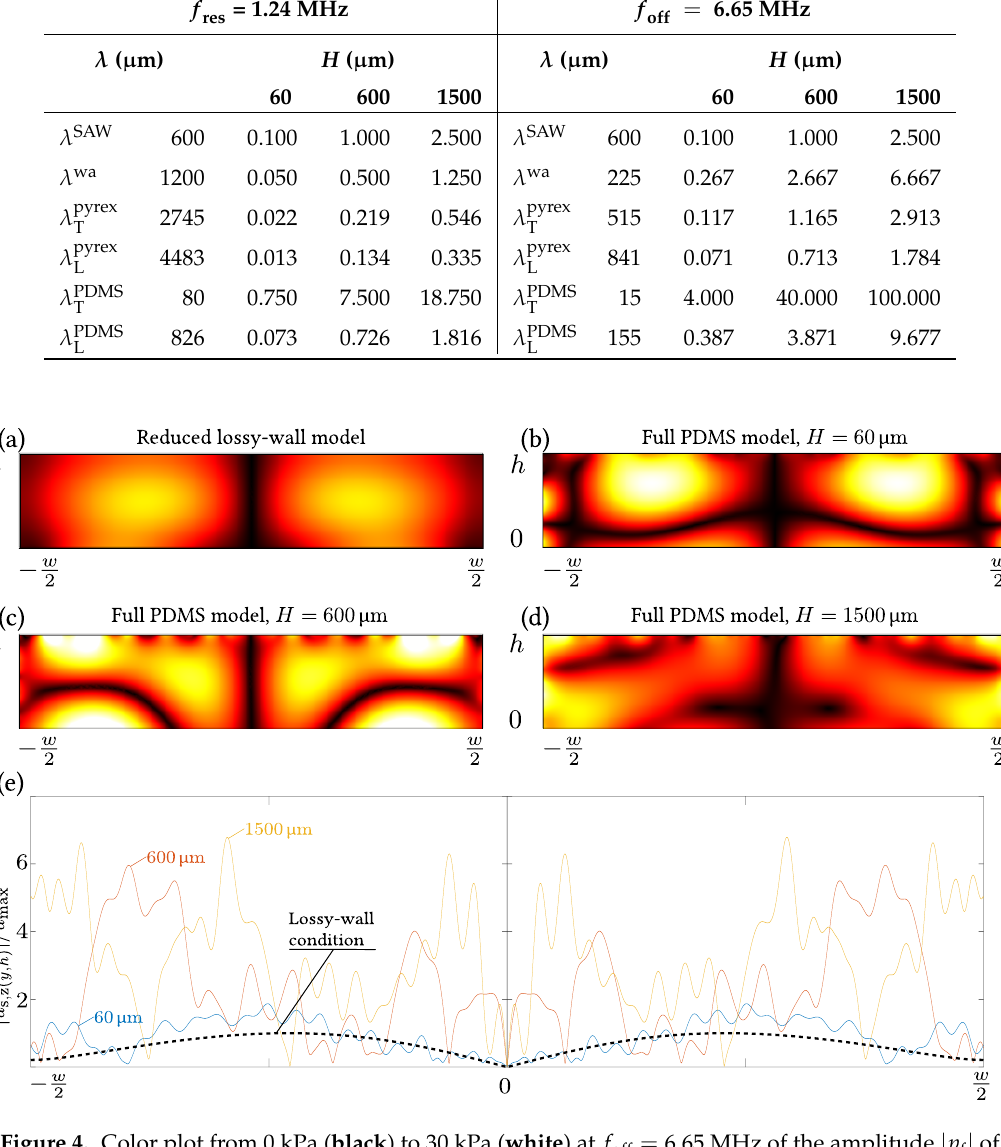
Figure 4. Color plot from 0 kPa ( black ) to 30 kPa ( white ) at f off = 6.65 MHz of the amplitude | p f | of the first-order pressure field p f in the fluid domain of ( a ) the reduced lossy-wall model and ( b – d ) the full PDMS model with wall thickness H = 60, 180, and 1500µm. The surrounding PDMS is not shown; ( e ) line plots of the normalized amplitude | u s , z ( y , h ) | / u max of the vertical displacement along the upper fluid-solid interface at z = h in the full model (full colored lines) with H = 60, 600, and 1500µm and in the reduced lossy-wall model (dashed black line). The normalization unit u max is the maximum amplitude found in the reduced lossy-wall